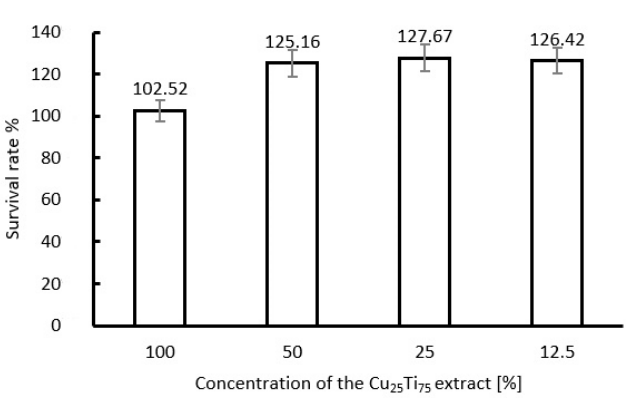
Figure 5. Proliferation of L929 cells exposed to various concentrations of the Cu 25 Ti 75 extract (8-day exposure, n = 3, clonogenic test), the results are presented in relation to the control (100%).